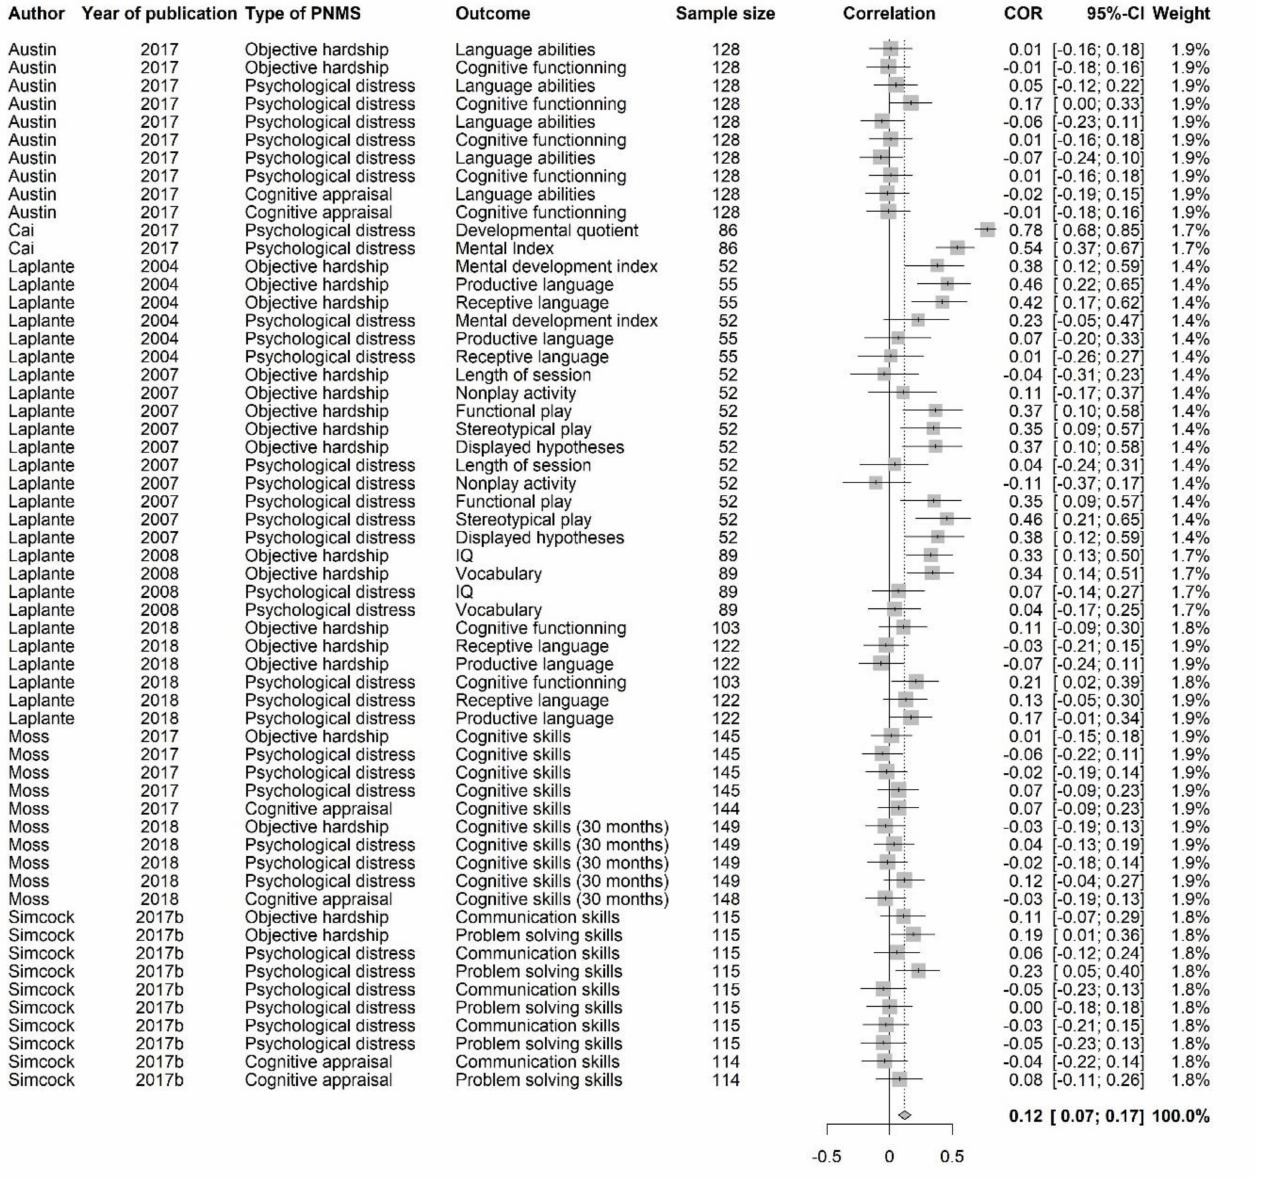
Figure 5. Cognitive outcomes forest